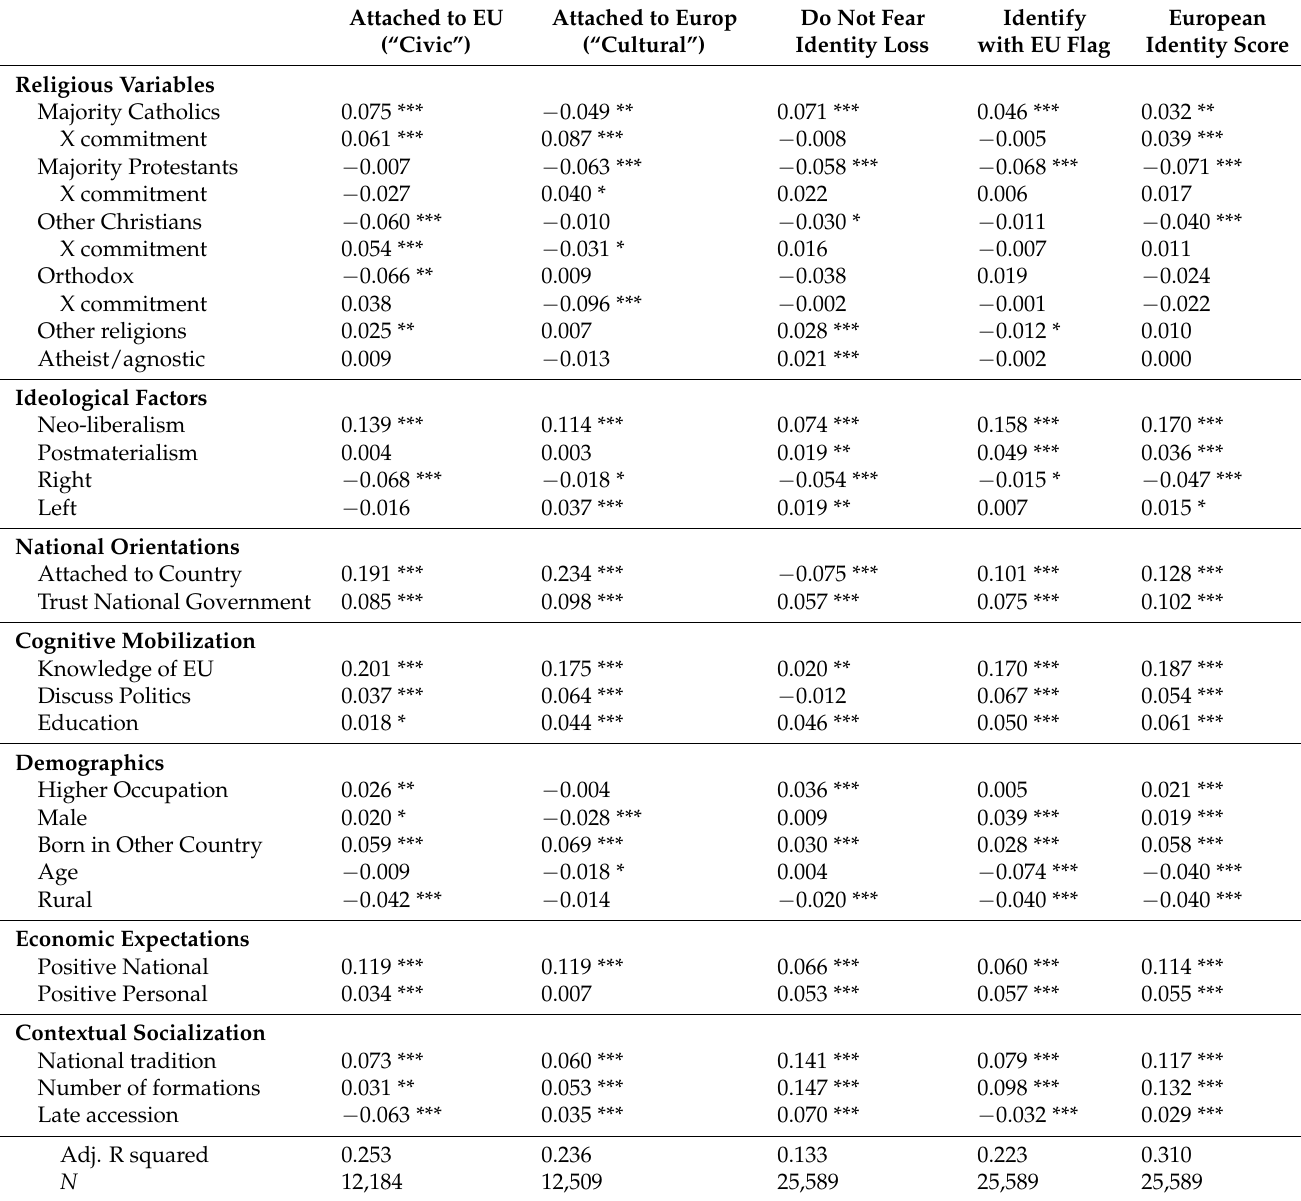
Table 3. European Identity, Individual Traits, and National Context (OLS regression betas